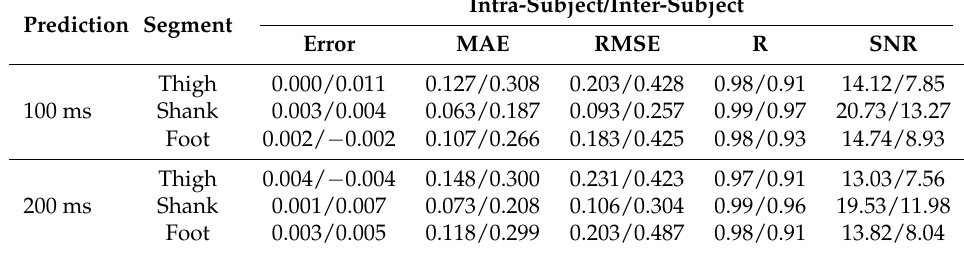
Table 1. Model performance for z-score normalized angular velocities of ipsilateral thigh, shank and foot segments for 100 and 200 ms ahead predictions of intra-subject and inter-subject implementations, shown as mean error, MAE, RMSE, R and signal to noise ratio (SNR). The sign of the error indicates the relative direction of the error; a negative error means that the average true value is lower than the average predicted value, and an error of zero indicates that the average predicted value was the same as the average true value.